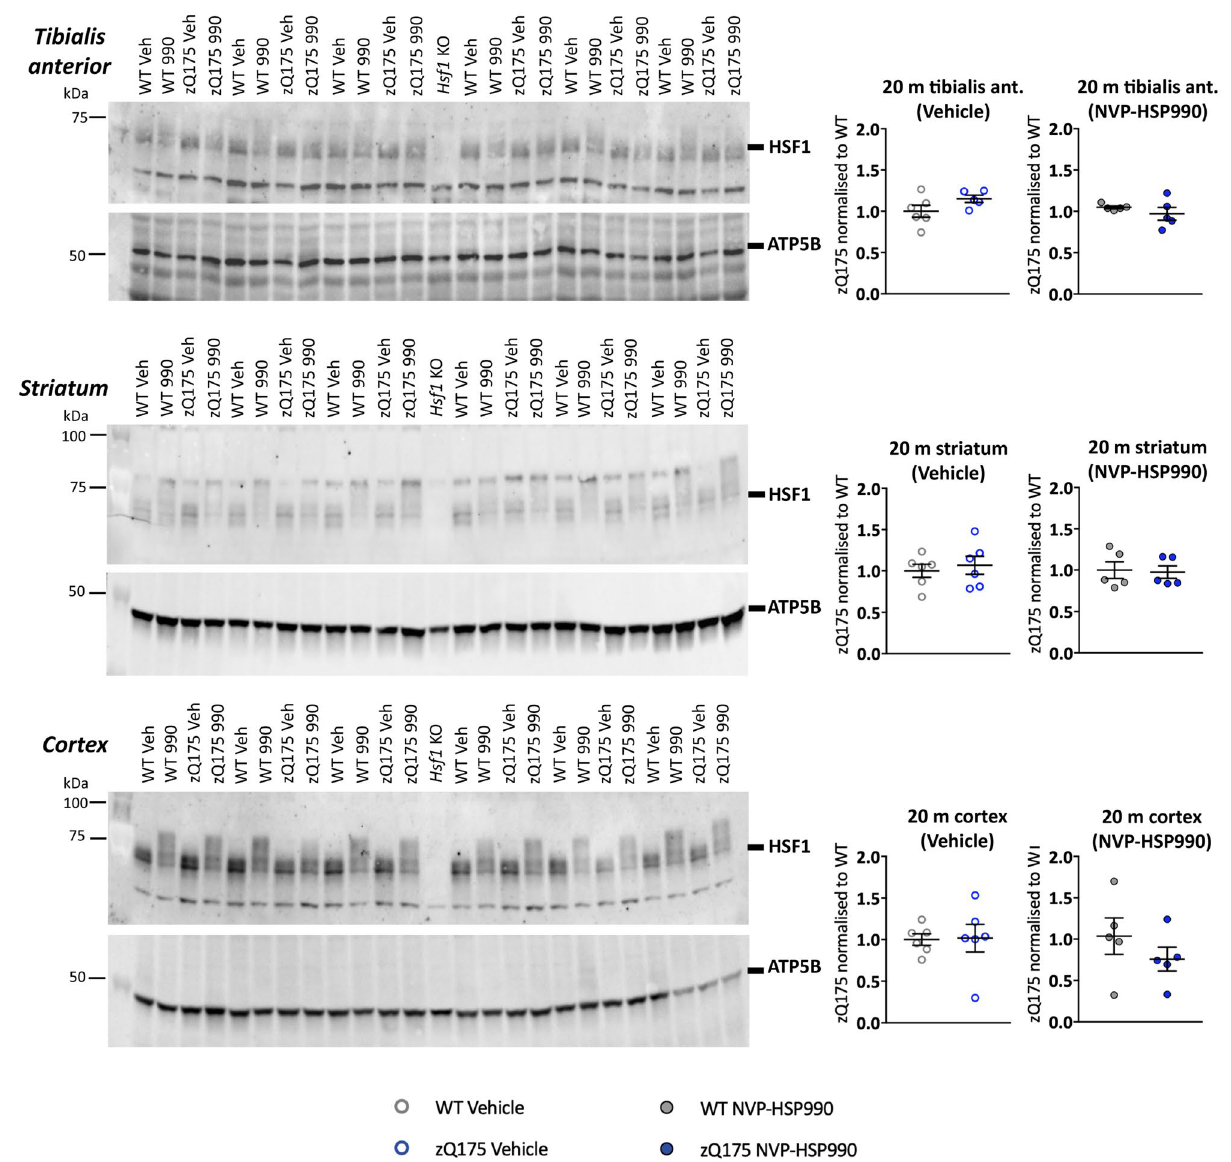
Figure 1. Neither basal nor activated levels of HSF1 change with disease progression in zQ175 tibialis anterior, striatum or cortex. On the left-hand side, western blot images showing HSF1 protein (top) or ATP5B (bottom) levels in tibialis anterior, striatum and cortex of zQ175 and wild-type mice treated with NVP-HSP990 or vehicle ( n = 5–6/genotype/treatment) at 20 months of age. HSF1 antibody 51034-1-AP (Proteintech) was used in cortex and tibialis anterior and antibody A303-176A (Bethyl Laboratories) in striatum. Quantification was performed separately for the vehicle and NVP-HSP990 treated samples and normalised to wild-type in each case (right-hand side). There were no statistically significant differences between the genotypes for either treatment. Statistical analysis was by unpaired Student’s t -test. Mean ± SEM. The test statistics can be found in Supplementary Table S6 online. Uncropped blots are presented in Supplementary Figs. S2–S4 online. Veh vehicle, 990 NVP-HSP990, WT wild-type, m months, KO knockout, ant. using a QuantiGene plex to measure the heat shock response in zQ175 mice, we assessed the kinetics of the pharmacological activation of the heat shock response after dosing with NVP-HSP990. Wild-type mice at nine weeks of age received an acute dose of NVP-HSP990 (12 mg/kg) or vehicle and brain hemispheres were collected at 4, 8, 12, 16 or 20 h after dosing ( n = 4/treatment/time point). Samples were processed for QuantiGene (8-plex) and the level of heat shock gene induction was determined (Supplementary Fig. S7 online)). The highest expres- sion level occurred at 4 h post-dosing for Hspa1a/b and between 4 and 8 h for Hspb1 and Dnajb1 , progressively returning to baseline levels by 20 h. Therefore, although the kinetics of induction for these three genes did not proceed at the same rate, 4 h after dosing was an appropriate time point to use for the following RNA-based experiments.